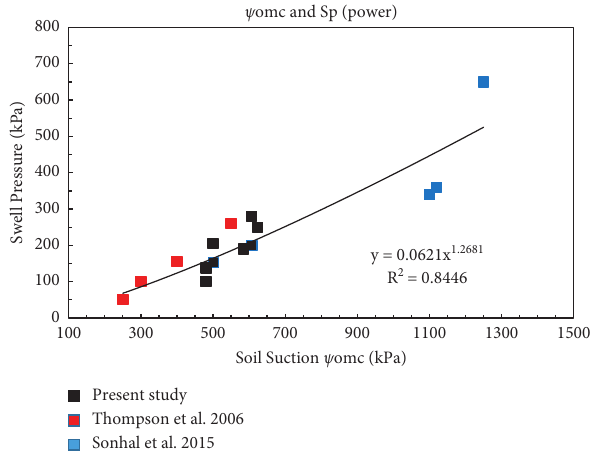
Figure 9: The newly developed suction-based correlation for swell pressure. Table 4: The summary of the newly proposed suction-based correlations with their respective R 2 values.